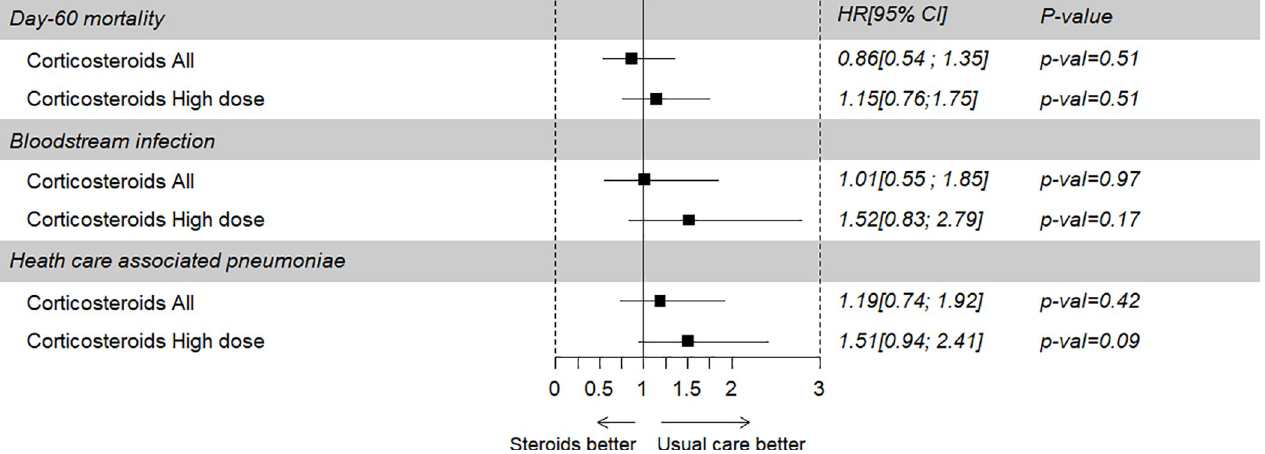
Fig 2. Effect of corticosteroids on ICU death and the occurrence of blood stream infection and HAP-VAP of patients in the main cohort. HAP-VAP: hospital-acquired pneumonia and ventilator-associated pneumonia; HR: Hazard ratio; CI: Confidence interval.